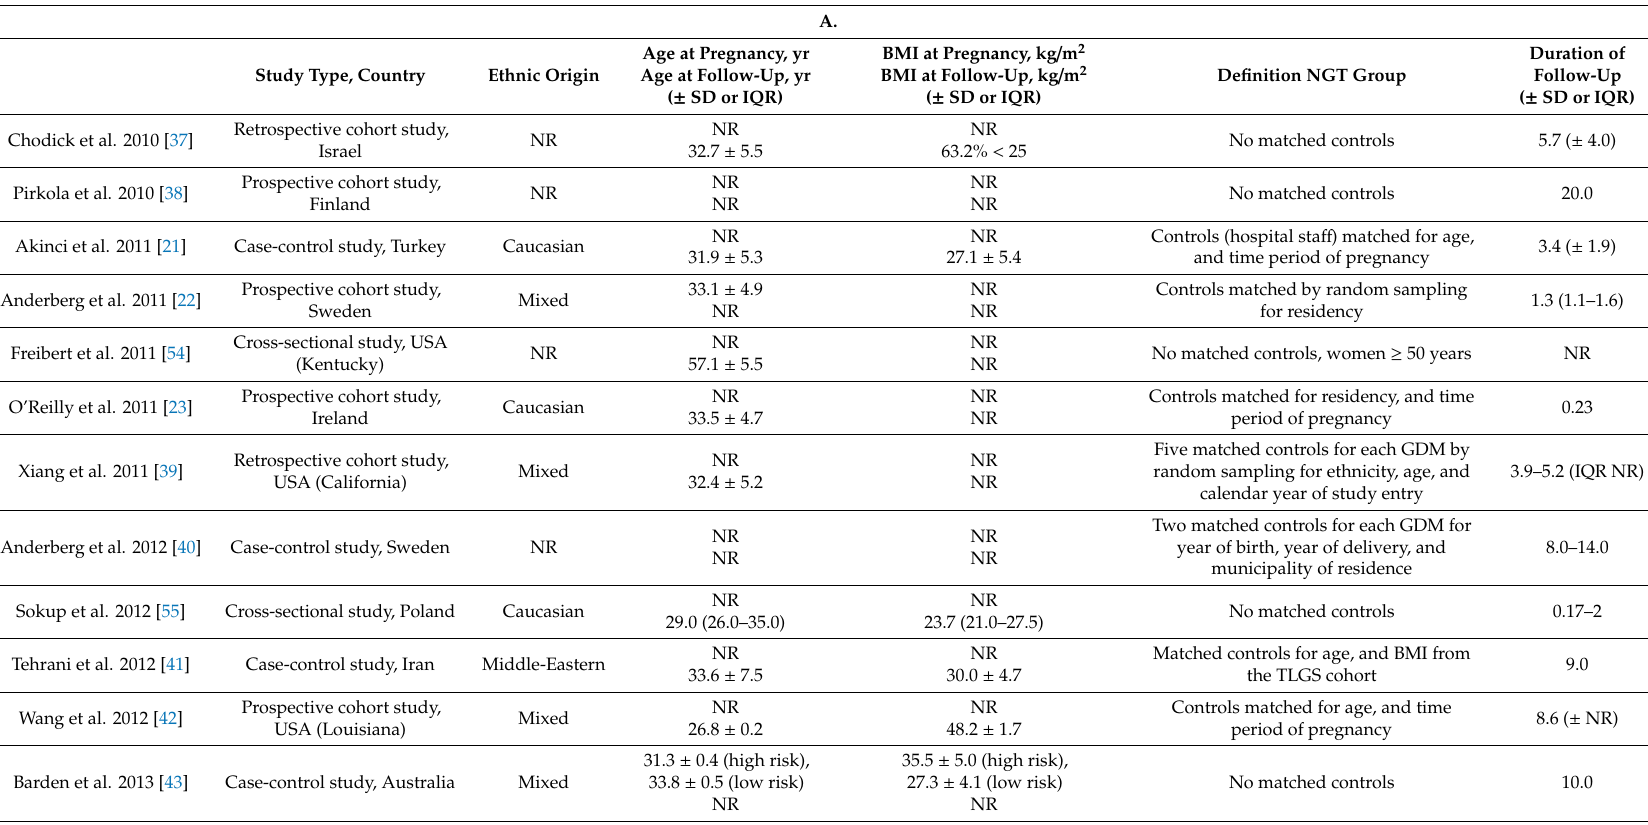
Table1. Thecharacteristicsofincludedstudies: ( A )studyandpatientcharacteristics, ( B )characteristicsconcerningGDM,T2DM,andprediabetes, and ( C ) characteristics concerning stroke and myocardial